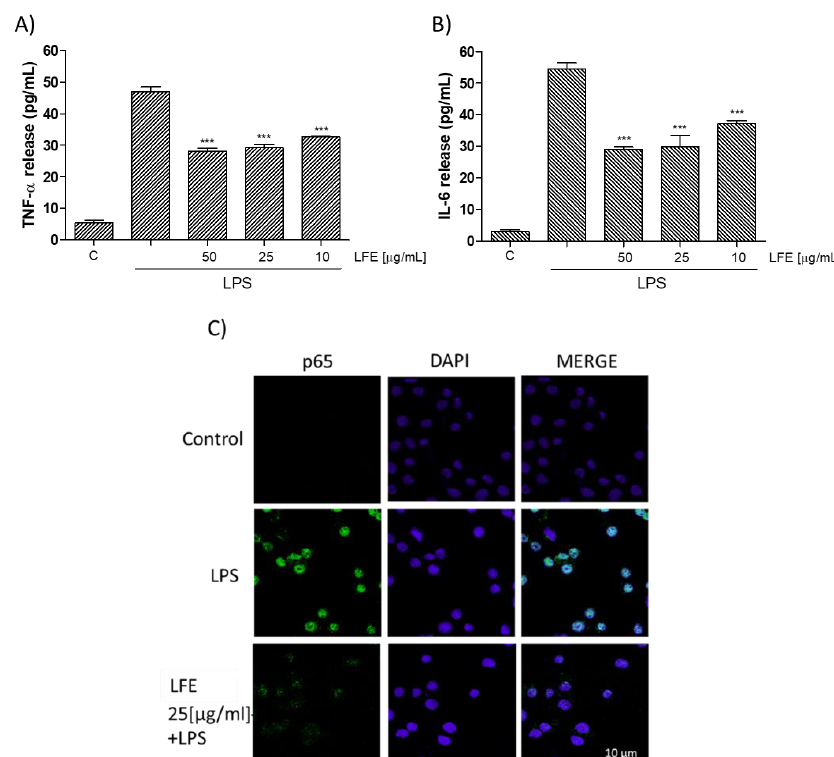
Figure 3. Effect of LFE (10 – 50 μg mL −1 ) on LPS – induced tumor necrosis factor (TNF)- α (Panel A) and interleukin (IL)-6 (Panel B) production in J774A.1 macrophages. TNF- α and IL -6 production was measured in the supernatants of J774A.1 cells treated with LFE (10 – 50 μg mL −1 ) and LPS (1 μg mL −1 ) for 18 h by means of Enzyme-Linked Immuno Sorbent Assay (ELISA). Values are expressed as mean ± s.e.m of at least three experiments, each in triplicate. Comparisons were performed using one-way analysis of variance and multiple comparisons were made by Bonferroni’s test. *** denotes p < 0.001 vs. LPS alone. Effect of LFE (25 μg mL −1 ) on LPS-induced p65 nuclear translocation (Panel C) in J774A.1 macrophages. Nuclear translocation of Nuclear factor-kB (NF-kB) p65 subunit was detected using immunofluorescence assay at confocal microscopy. Scale bar, 10 µm. Blue and green fluorescence indicate localization of nucleus (DAPI) and p65, respectively. Analysis was performed by confocal laser scanning microscopy.